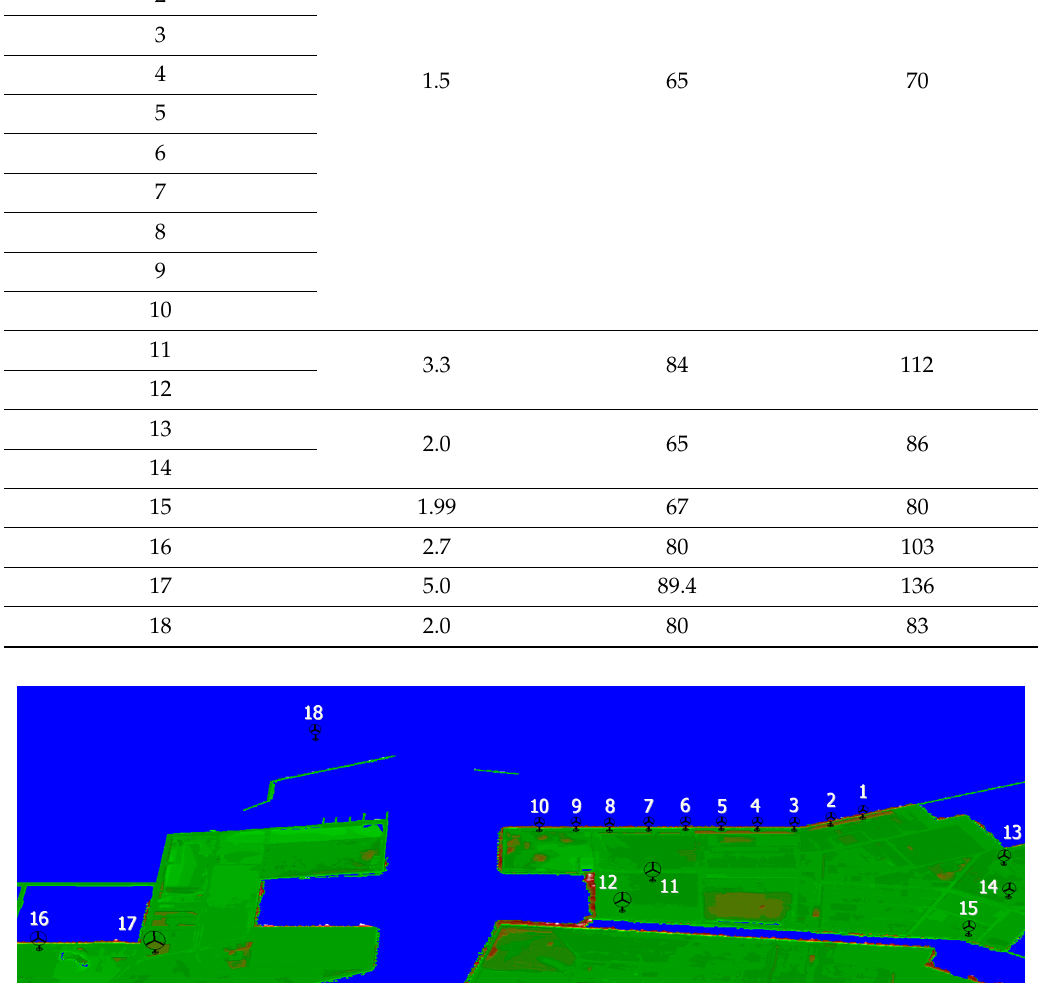
Table A1. Main specification information of each wind turbine.